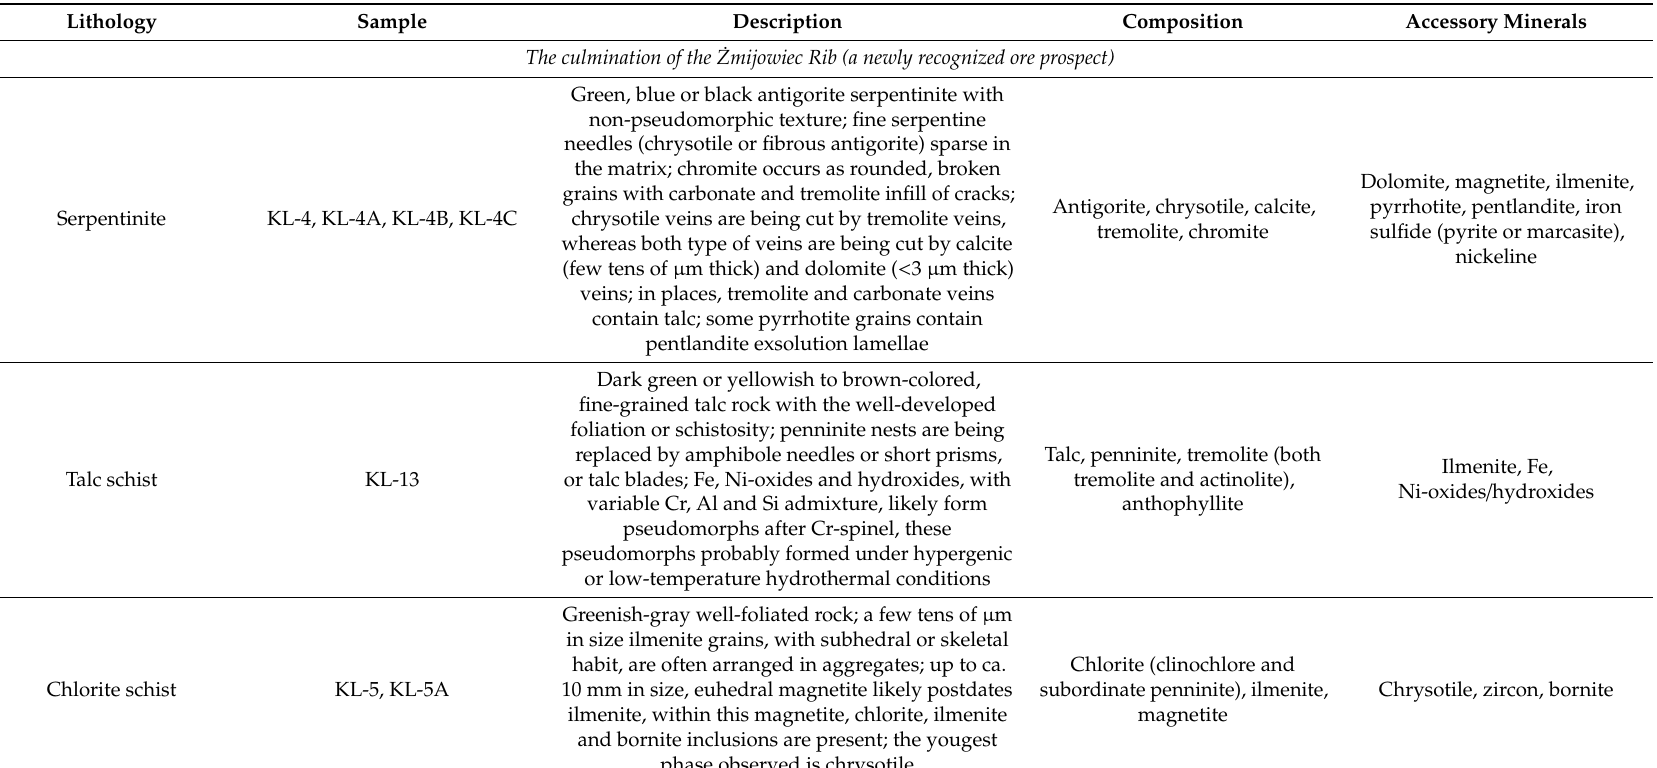
Table 1. Description of the examined samples from the Kletno